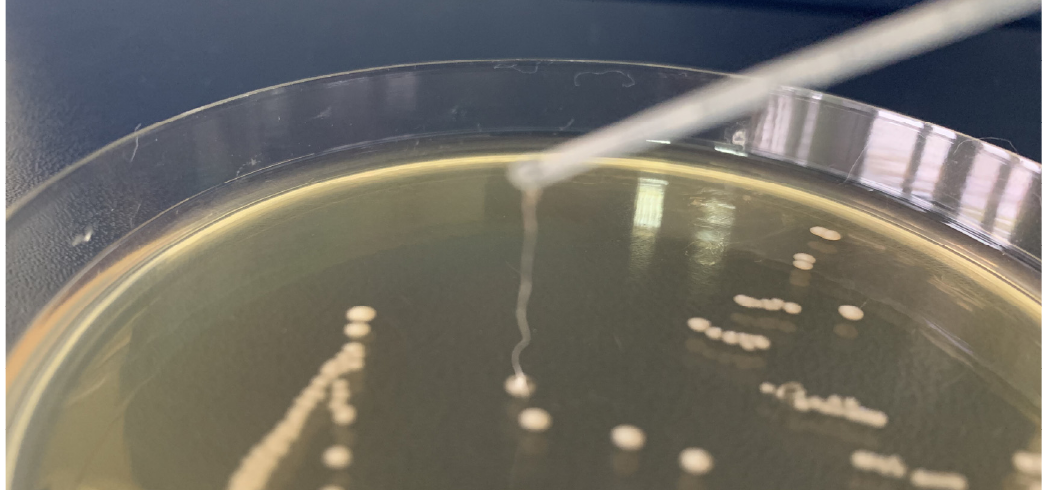
Int. J. Mol. Sci. 2022 , 23 , 14382 Figure 7. “Ropy” phenotype of Limosilactobacillus fermentum MC1 strain. Figure 7. “Ropy” phenotype of Limosilactobacillus fermentum MC1 strain.